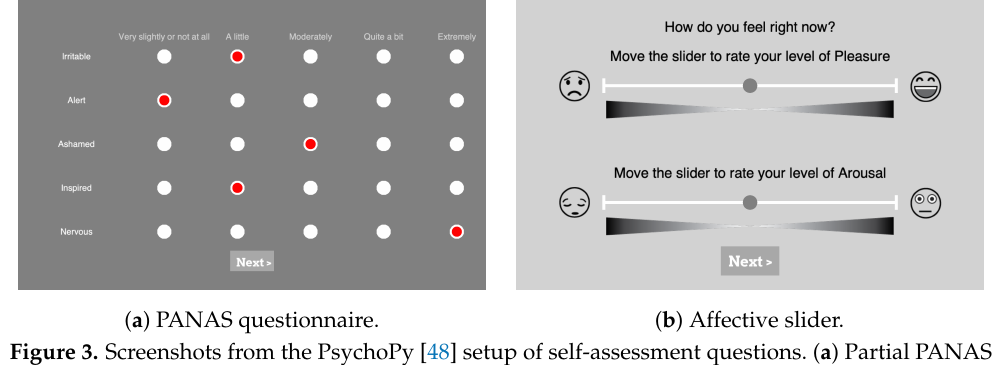
Figure 3. Screenshots from the PsychoPy [48] setup of self-assessment questions. ( a ) Partial PANAS questionnaire with five different levels represented by clickable radio buttons (in red) with the levels’ explanation on top, ( b ) AS for valence displayed on top and the slider for arousal on the